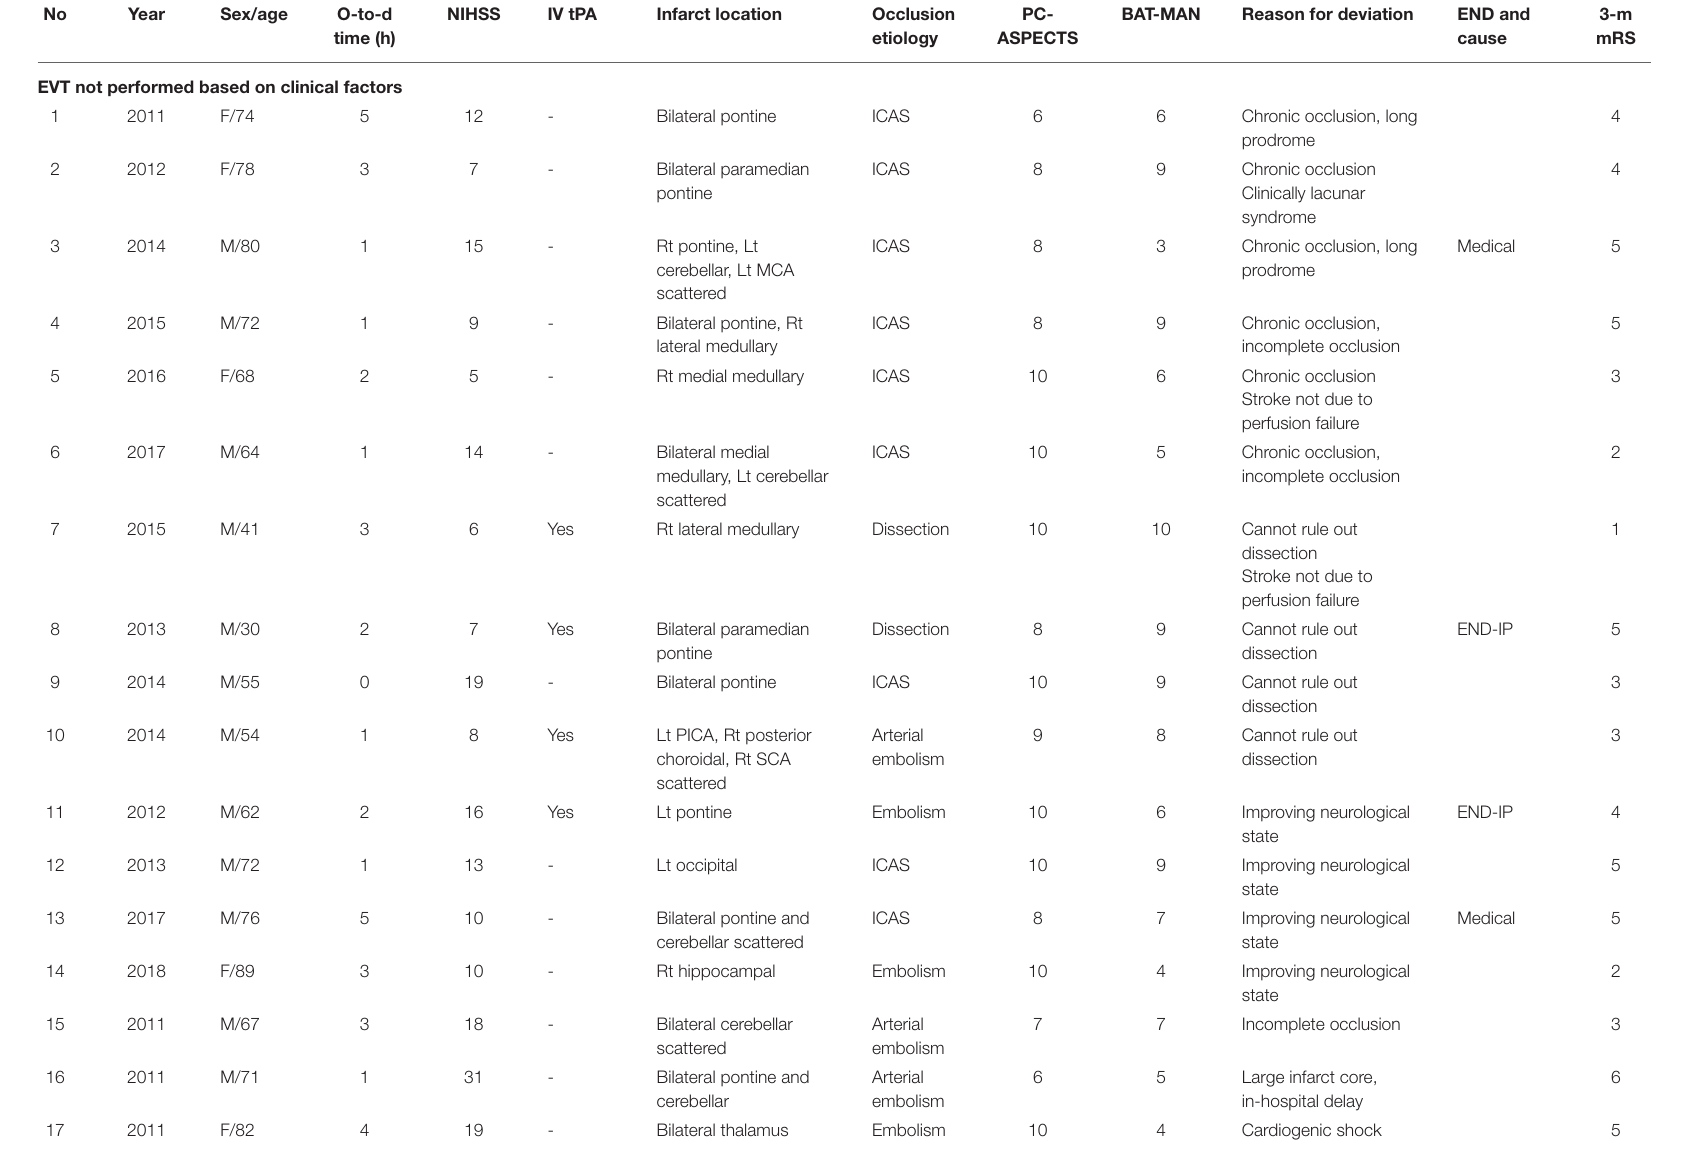
TABLE 6 | Brief description of patients who met the institutional indication for EVT decision, however did not receive EVT.